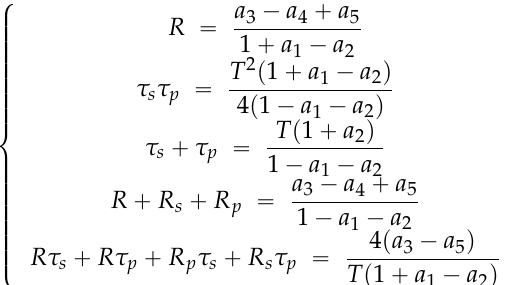
Figure 6. HPPC pulse current.